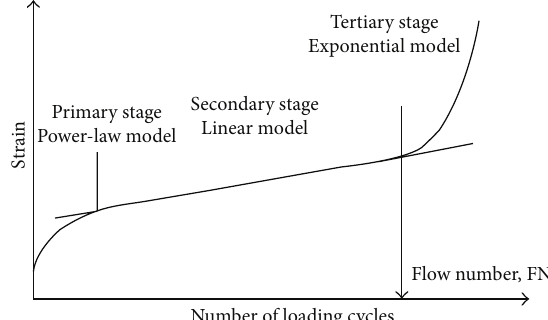
Figure 1: Cumulative permanent strain versus number of loading cycles